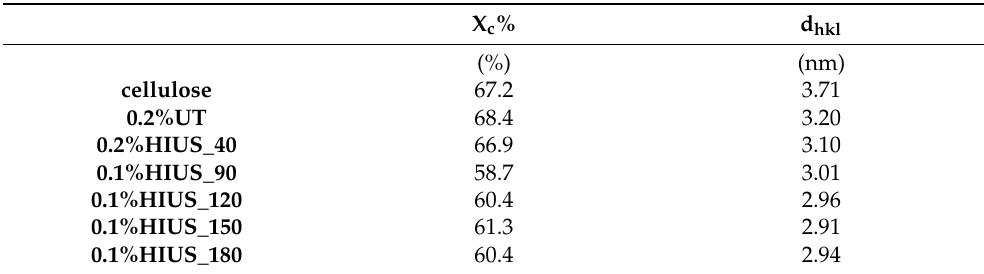
Table 2. The crystallinity index and thickness of crystallites of cellulose isolated from hop stems after different duration of HIUS treatment.